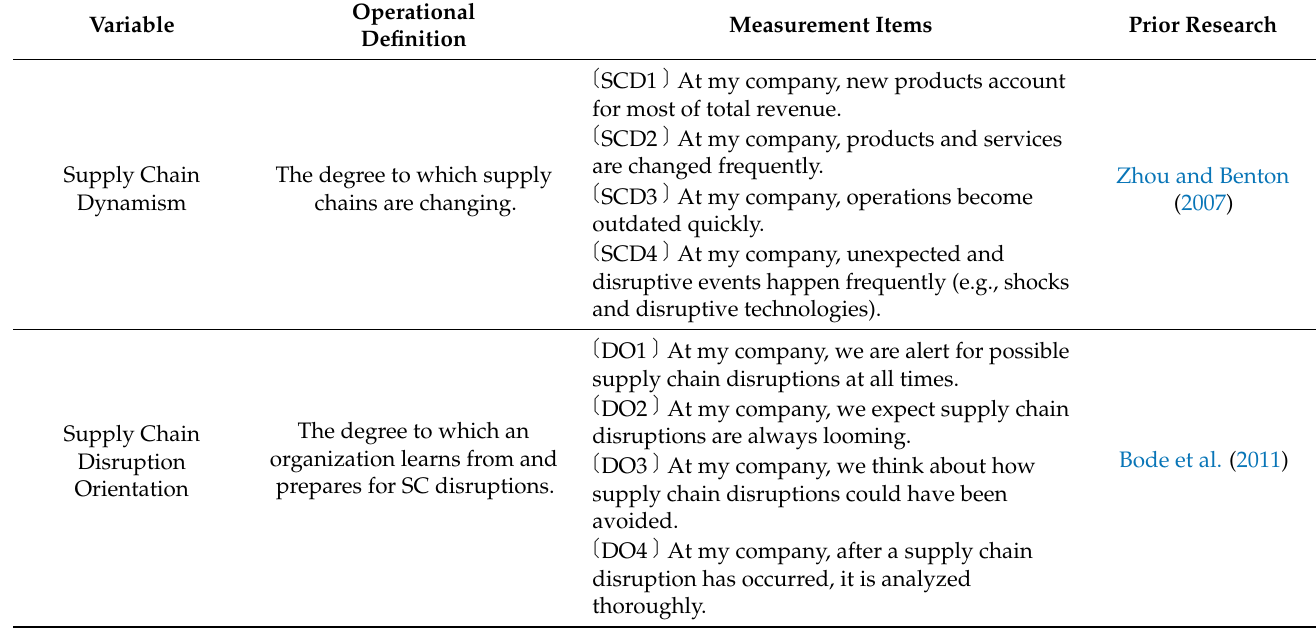
Table 2. Operationalization of the Research